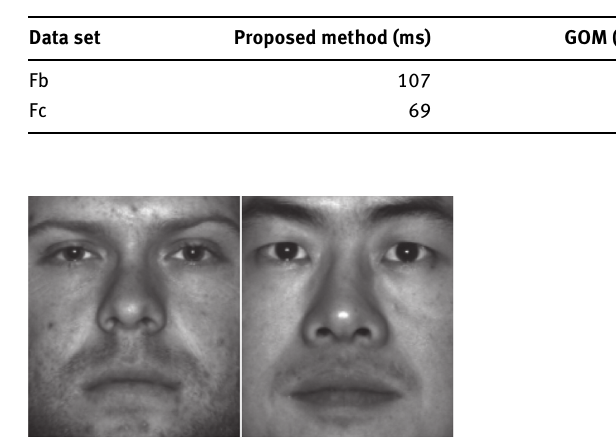
Figure 13: Examples of Extended YaleB Database Images.